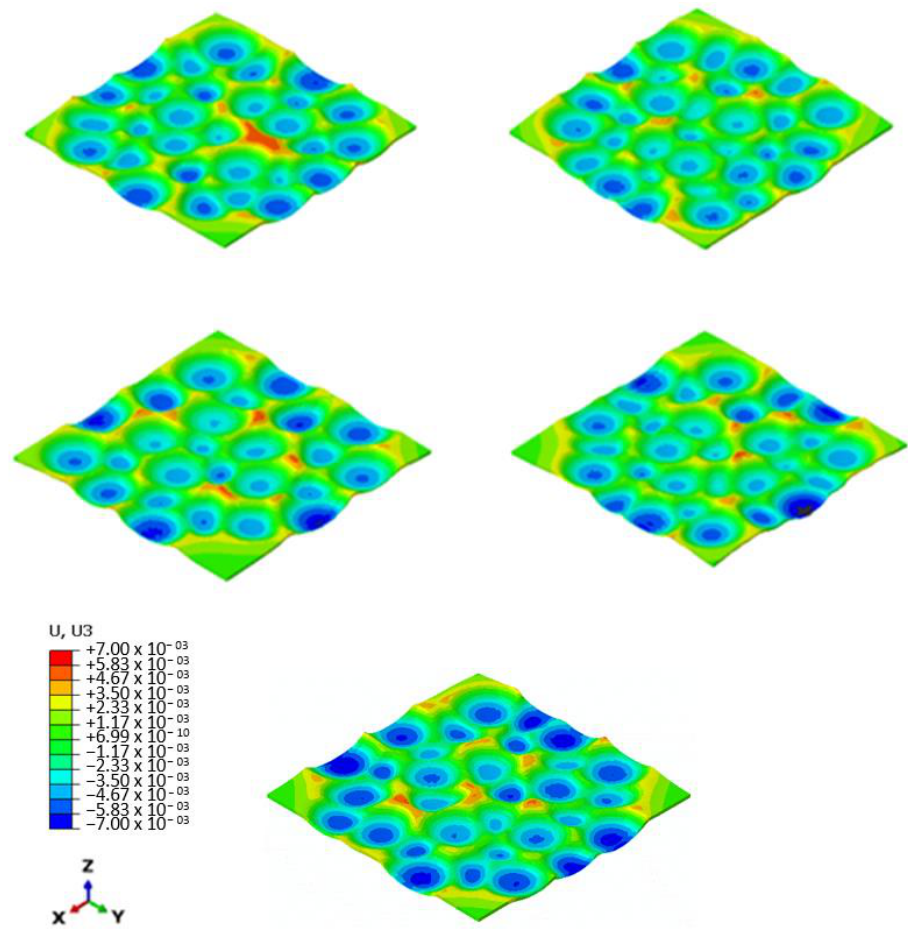
Figure 6. Qualitative comparison of the top surface morphology of the numerical simulations per- formed using the same process parameters but with different shot arrangements and impact se- quences.